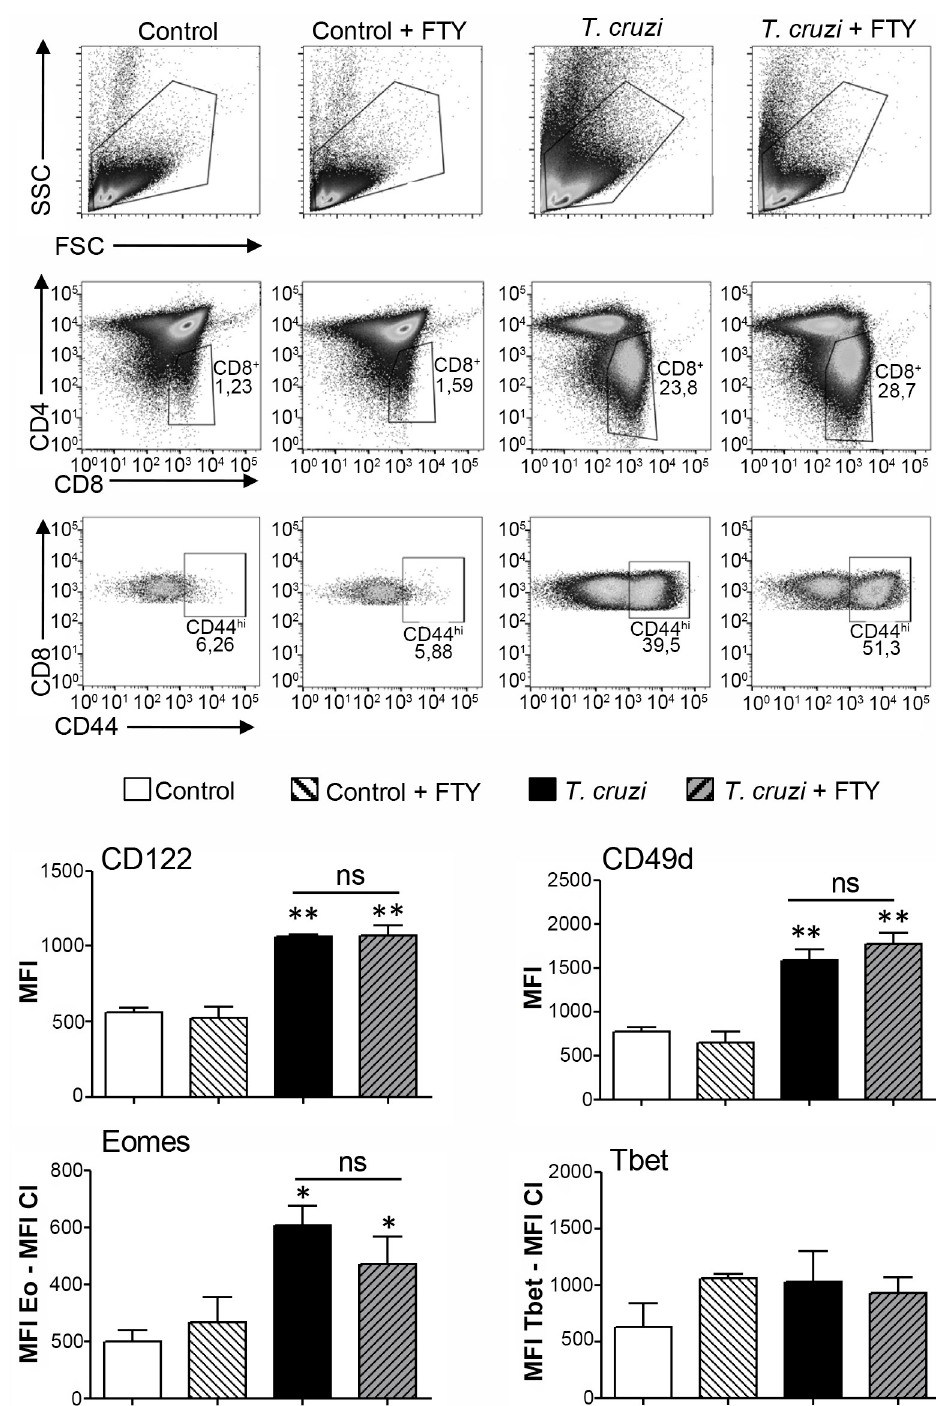
Fig 3. Innate CD8 + cells in the thymus of T . cruzi -infected mice are not derived from SLO. Control or T . cruzi - infected (Tulahuen) WT mice were treated with FTY720. Individual mice from both groups received 3 25 μ g injections of FTY720 in 200ul of saline solution on days 8, 10 and 13 post-infection. Control mice received saline only injections on the indicated days. Thymocytes from control or T . cruzi -infected mice, with and without FTY720 treatment, were obtained 14 days post-infection. The expression of CD122 and CD49d was evaluated by flow cytometry in SP8 CD44 hi cells. Eomes and Tbet expression was measured by intranuclear staining using Flow cytometry analysis in the SP8 CD44 hi cells and expressed as described in Fig 2. One-way ANOVA was used for statistical analysis. Data are shown as the mean ± SEM. Control versus T . cruzi -infected mice, � p < 0.05, �� p < 0.01. FTY = FTY720. https://doi.org/10.1371/journal.ppat.1007456.g003 PLOS Pathogens| https://doi.org/10.1371/journal.ppat.1007456 January4,